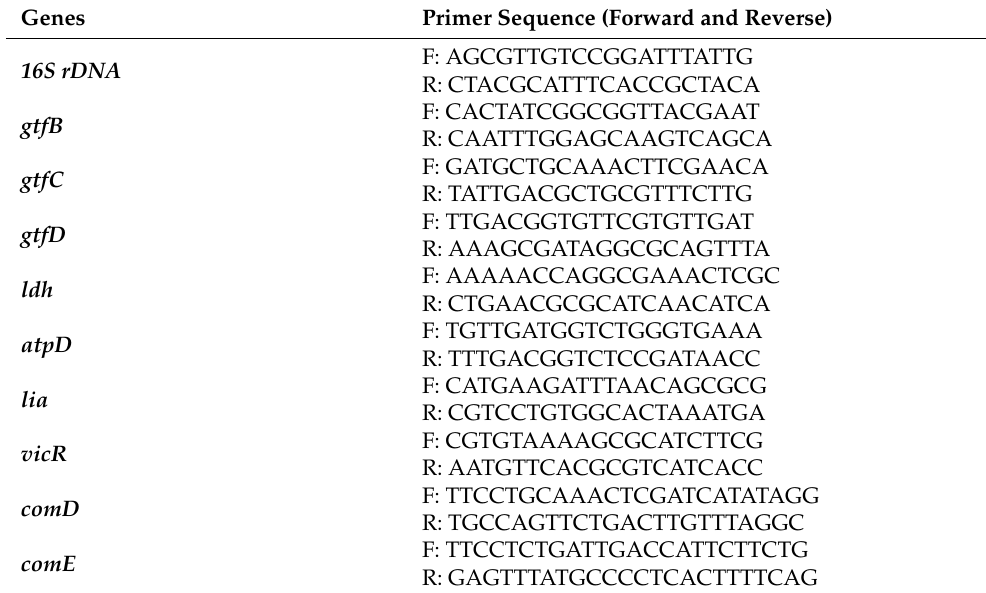
Table 2. Specific primers for the S. mutans virulence-associated genes. Genes Primer Sequence (Forward and